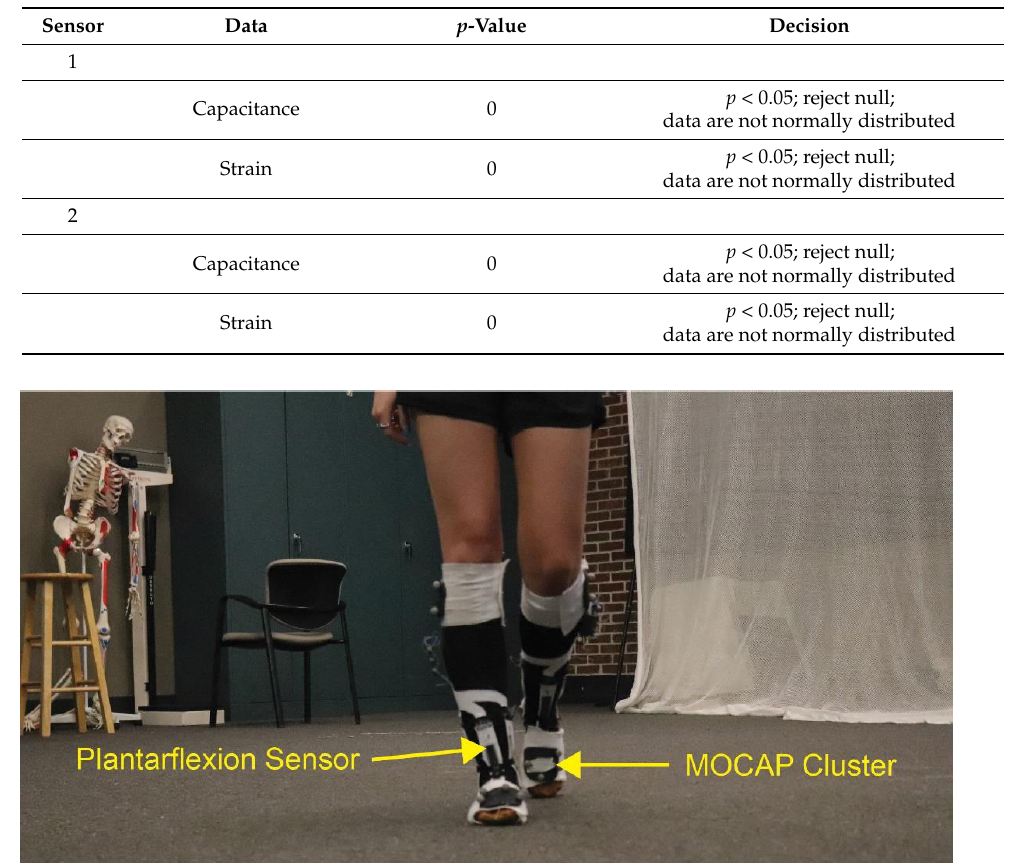
Table 3. Spearman’s Rank Correlation Coefficients for the Quasi -Static Strain and Capacitance at Each Speed.